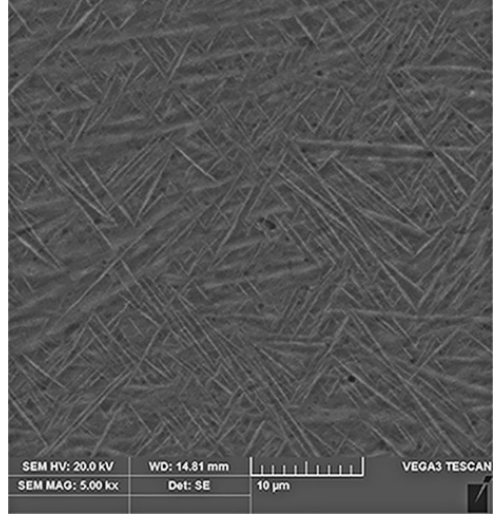
Figure 5. Basketweave microstructure.